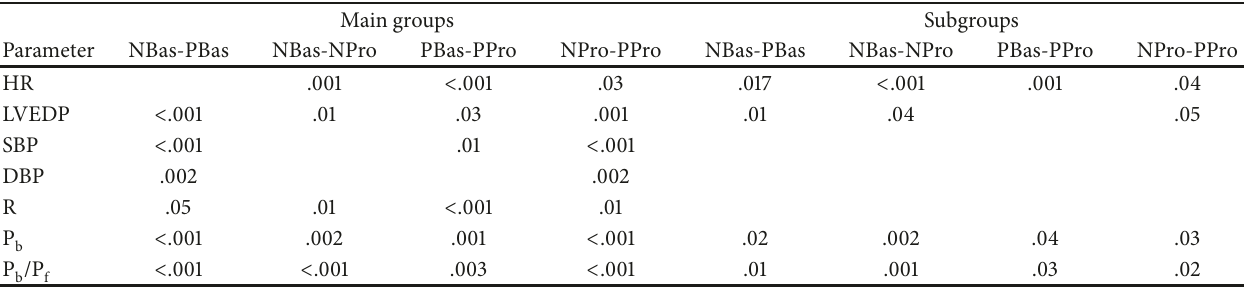
Table 3: Statistical results of only those parameters in Table 2 with statistically significant between-subjects effects for the main groups and subgroups .